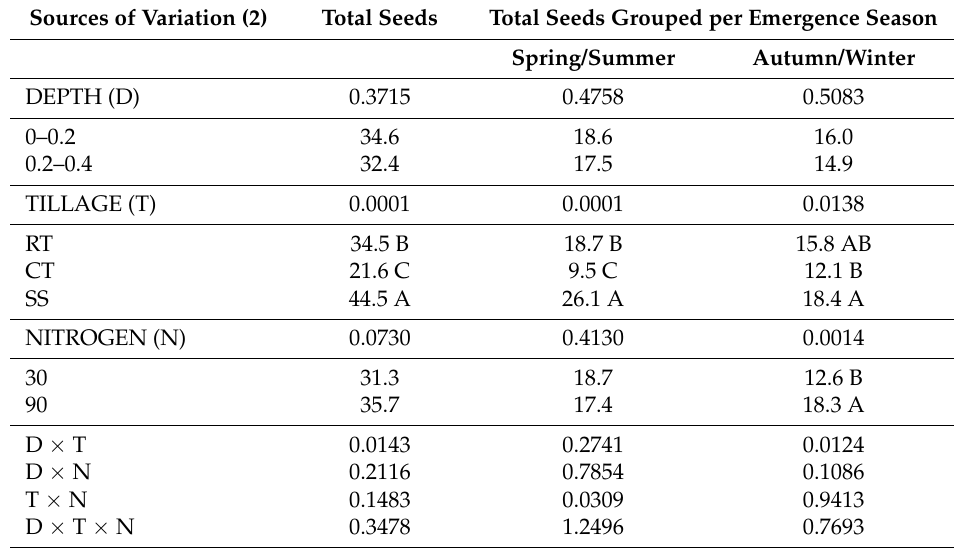
Table 2. Effect of soil depth (D, m), tillage system (T), and nitrogen supply (N, Kg ha − 1 ) on weed seed bank (1). Sources of Variation